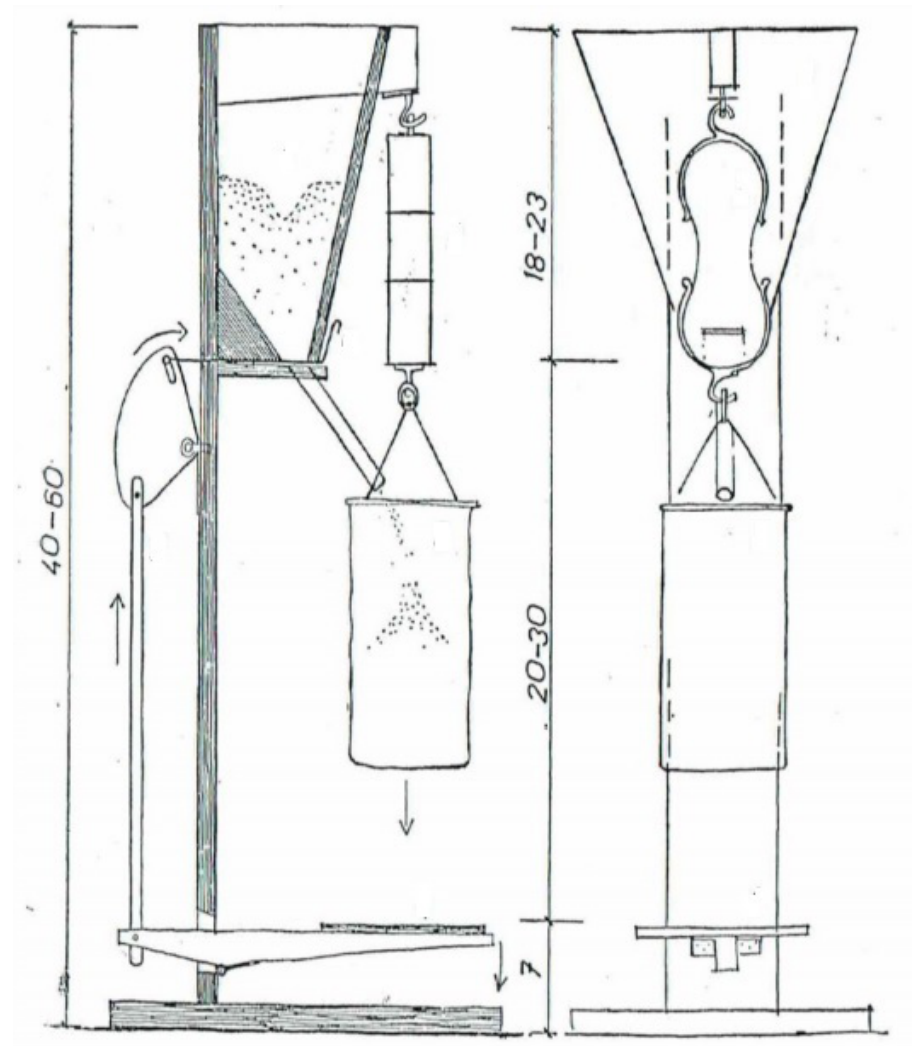
Figure 2. Test of binding capacity